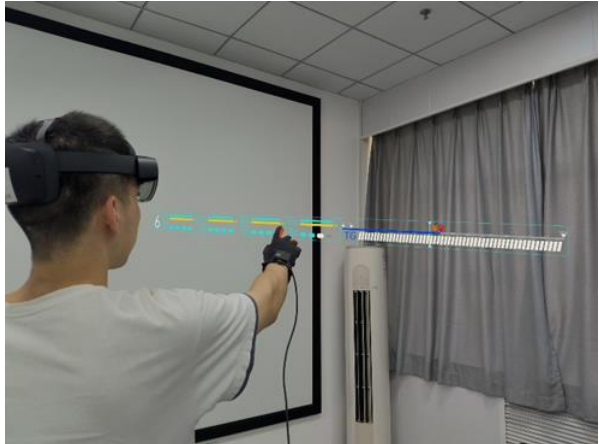
Figure 6. The scene of mixed reality combination in Experiment 2.